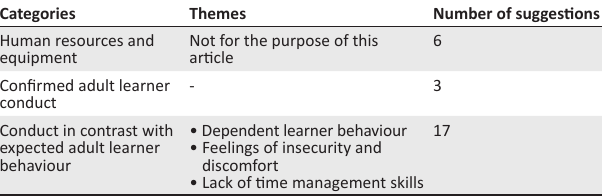
TABLE 1: Secondary analysis